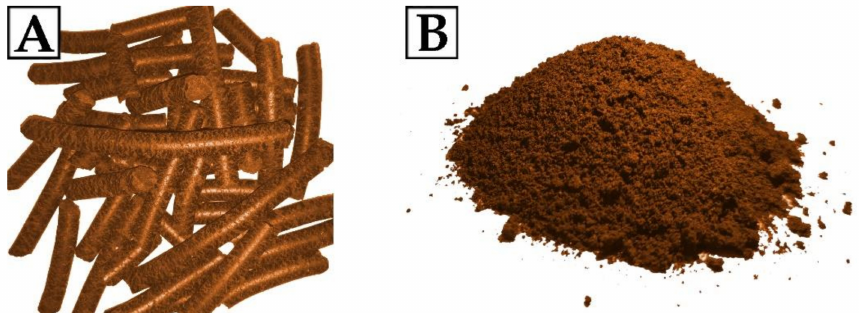
Figure 8. Evening primrose oil cake: ( A ) pellet, ( B ) ground